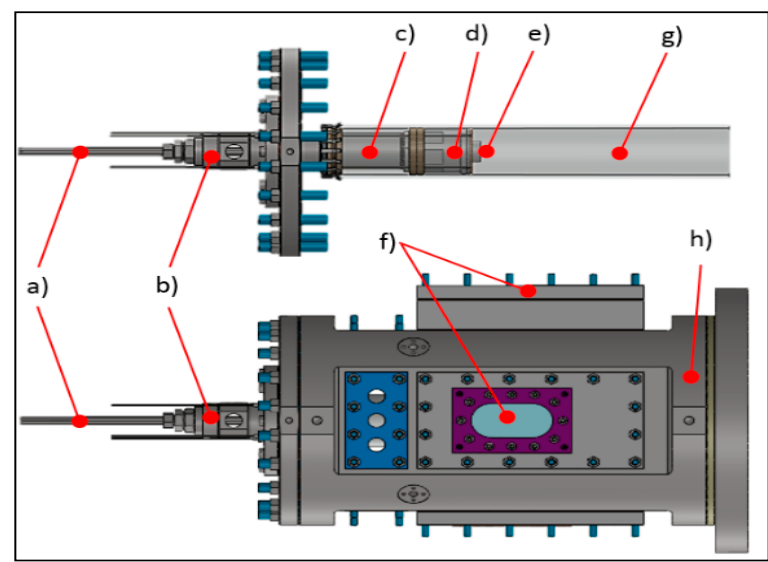
Figure 1. Experimental rig ( a ) instrumentation and pilot injection lance, ( b ) inlet plenum, ( c ) mixing plenum, ( d ) radial-tangential swirler insert, ( e ) exit nozzle, ( f ) quartz window, ( g ) quartz confinement, and ( h ) high-pressure optical combustor (HPOC) casing. Energies 2020 , 13 , x FOR PEER REVIEW Table 1. Boundary conditions; atmospheric conditions.